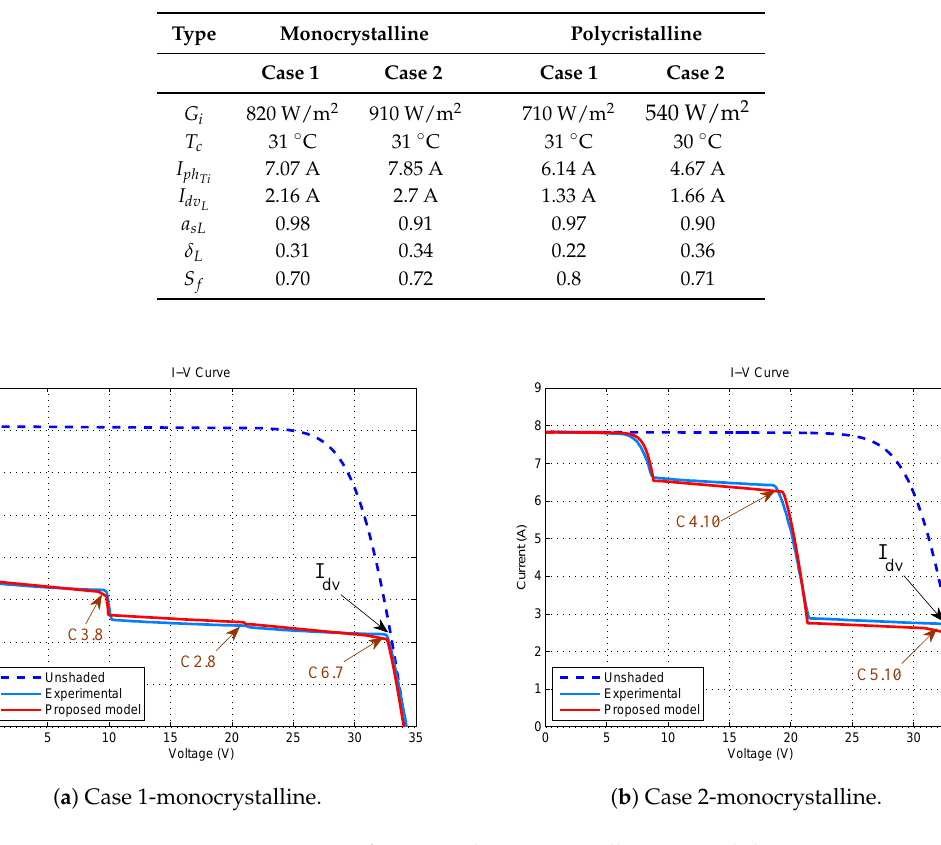
Figure 17. I–V curves for test with monocrystalline PV